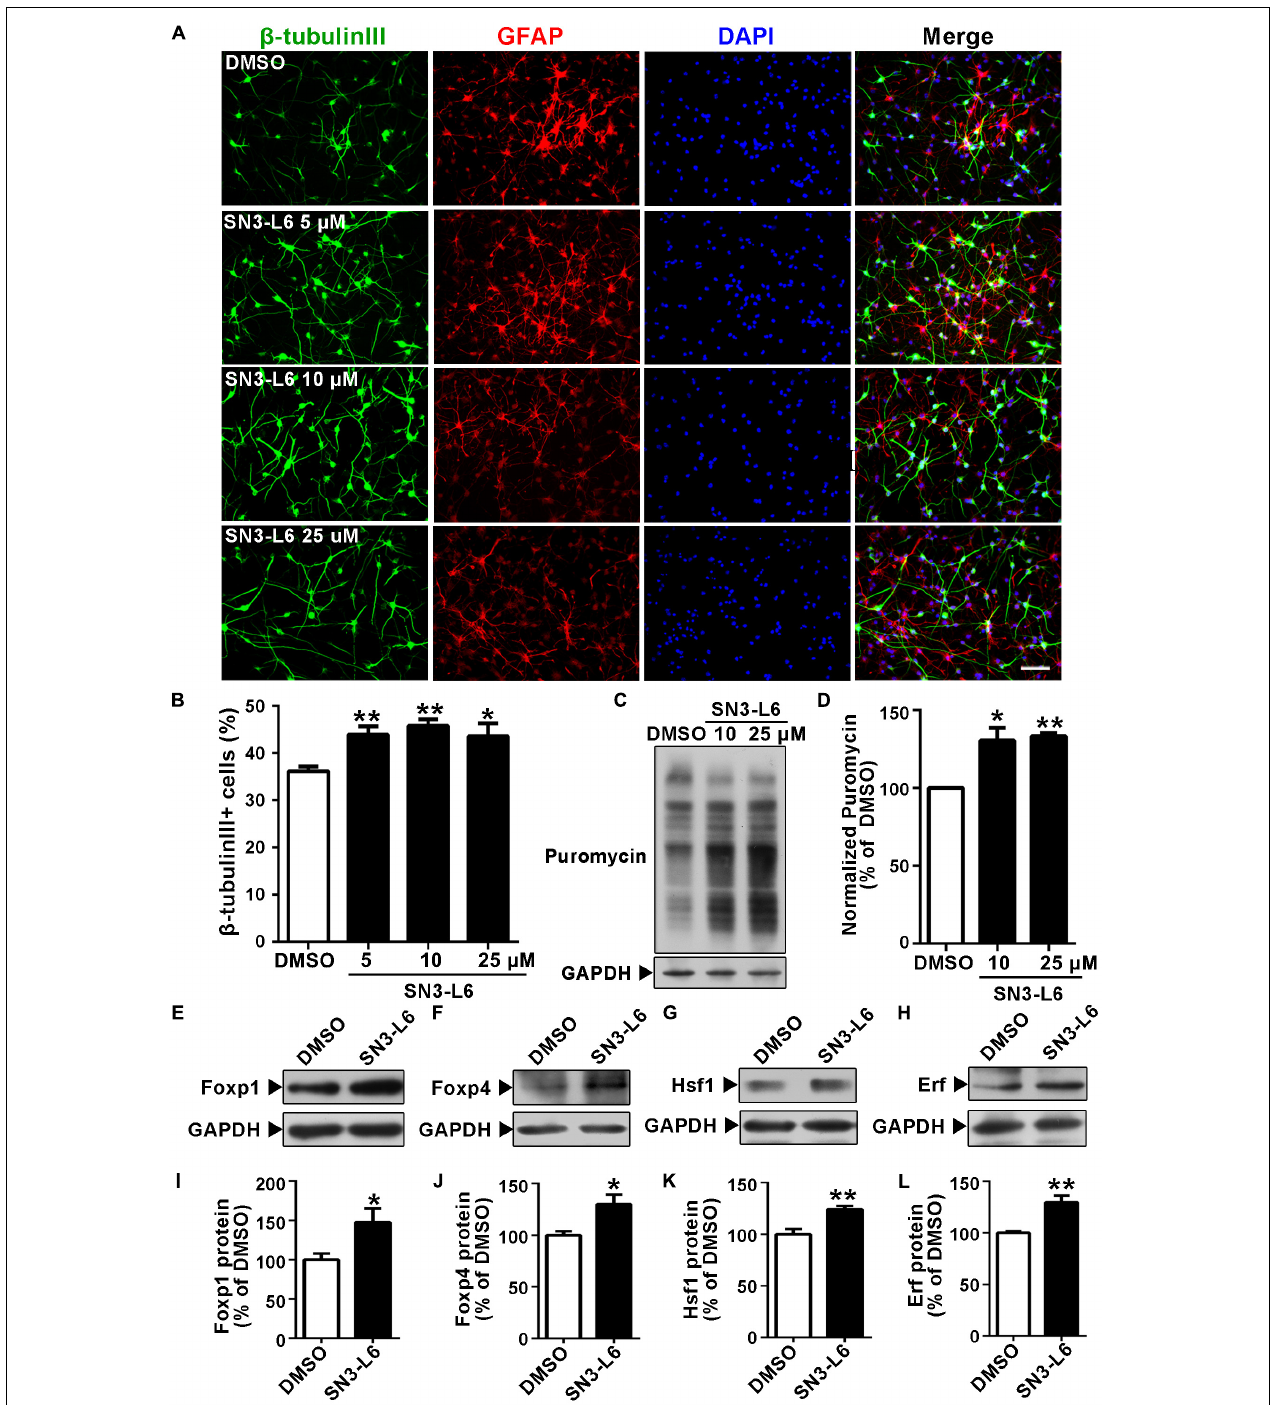
FIGURE 8 | SN3-L6 promotes neuronal differentiation in cortical neural progenitor cells (NPCs). (A) Primary NPCs were differentiated for 5 days in the presence of DMSO or different concentrations of SN3-L6. Neurons and glial cells were immunostained with β -tubulin III (green) and GFAP (red), respectively. Nuclei were counterstained with DAPI. Scale bar, 50 µ m. (B) Quantification of β -tubulin III + cells differentiated from NPCs. Data are presented as mean ± SEM from four independent experiments. ∗ P < 0.05, ∗∗ P < 0.01, SN3-L6 vs. DMSO, one-way ANOVA with Bonferroni multiple comparison test. (C) Effects of SN3-L6 (10 or 25 µ M) on puromycin incorporation. (D) Puromycin levels were quantified and presented as percentage of change comparing to DMSO. ∗ P < 0.05, ∗∗ P < 0.01, SN3-L6 vs. DMSO. Error bars represent SEM from three independent experiments, one-way ANOVA with Bonferroni multiple comparison test. (E–H) Western blot analysis of protein levels of Foxp1, Foxp4, Hsf1, and Erf in NPCs after treatment of SN3-L6 (10 µ M). (I–L) Quantification of protein level changes comparing to DMSO. Error bars represent SEM. Three independent experiments were performed. ∗ P < 0.05, ∗∗ P < 0.01, SN3-L6 vs. DMSO, unpaired Student’s t -test.